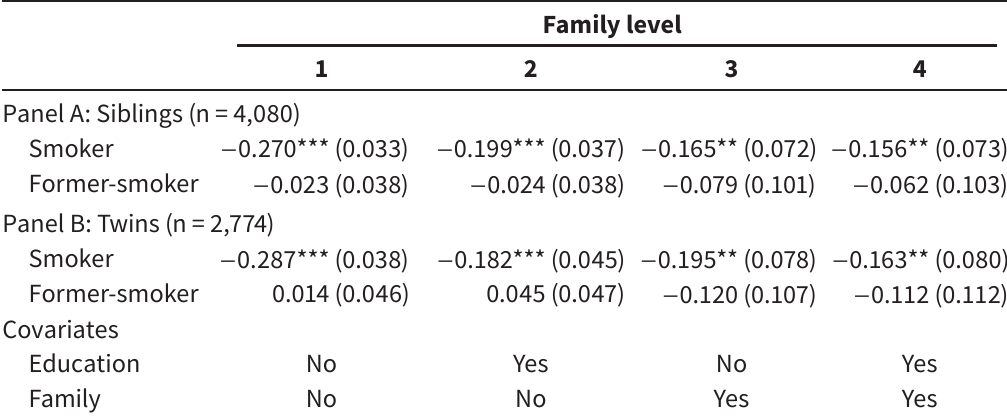
The earnings impact of smoking for the family sample Family level 1 2 3